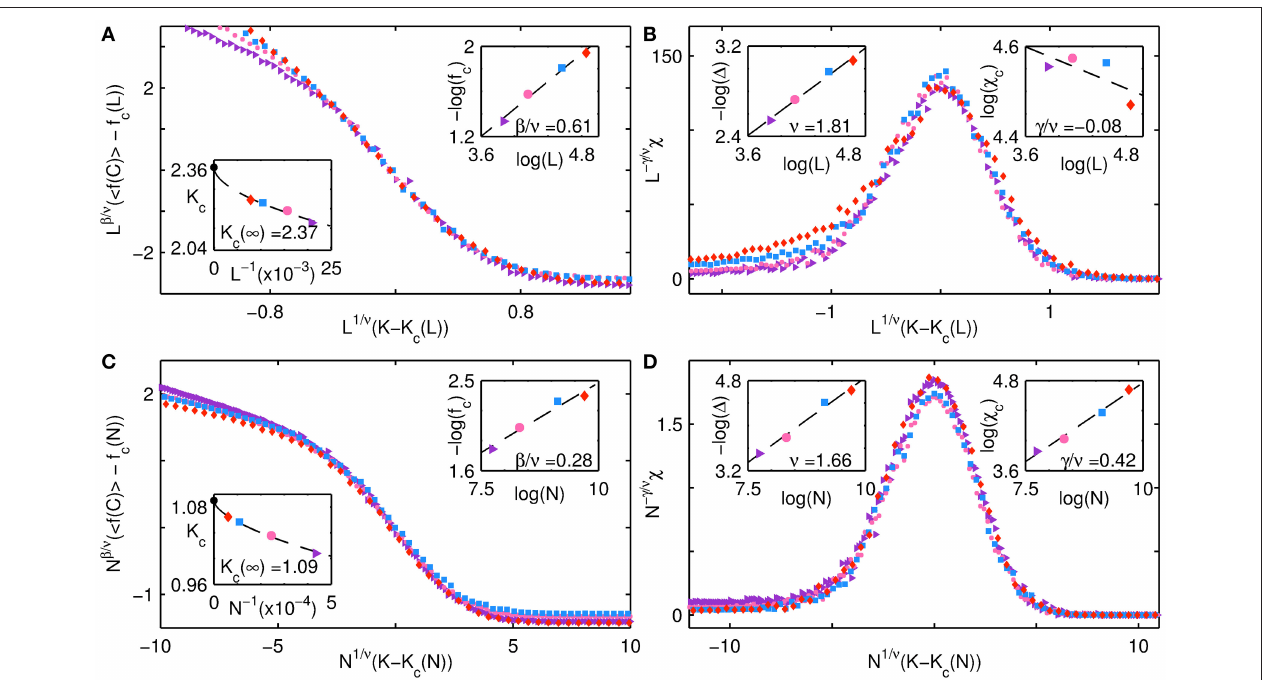
FIGURE 5 | Collective behavior of a network of agents at the interface of all D and fluctuating regimes for different system sizes. Finite-size scaling results are shown f ( C ) for the cases (A,B) p 0, b 0.96, and (C,D) p 1, b 1.05. (A,C) show the order parameter, viz., mean fraction of cooperators (averaged over 10 3 trials), = = = = h i while (B,D) show the corresponding dependence of the susceptibility χ [obtained from Equation (2) using values of f ( C ) obtained over 10 3 trials] on K . The abscissae of each of the panels represents the deviation of the noise K from the critical noise value K c ( N ), scaled by N 1 /ν . The ordinate for (A,C) shows the deviation of the order parameter from its value f c ( N ) at the critical point K c ( N ), scaled by N β/ν , while the ordinate for (B,D) shows the susceptibility scaled by N γ/ν . The curves are seen to collapse upon using exponent values obtained from finite-size scaling, viz., (A,B) ν 1.81 0.14, β/ν 0.61 0.05, γ/ν 0.08 0.06 and (C,D) = ± = ± = − ± ν 1.66 0.14, β/ν 0.28 0.04, γ/ν 0.42 0.03. The insets in (A,C) show the least-square fits of Equation (3) to K c and log ( f c ) to log ( N ), while the insets in = ± = ± = ± (B,D) show the least-square fits of log ( 1 c ) to log ( N ) and log ( χ c ) to log ( N ). Different symbols are used to indicate the different system sizes N for which the